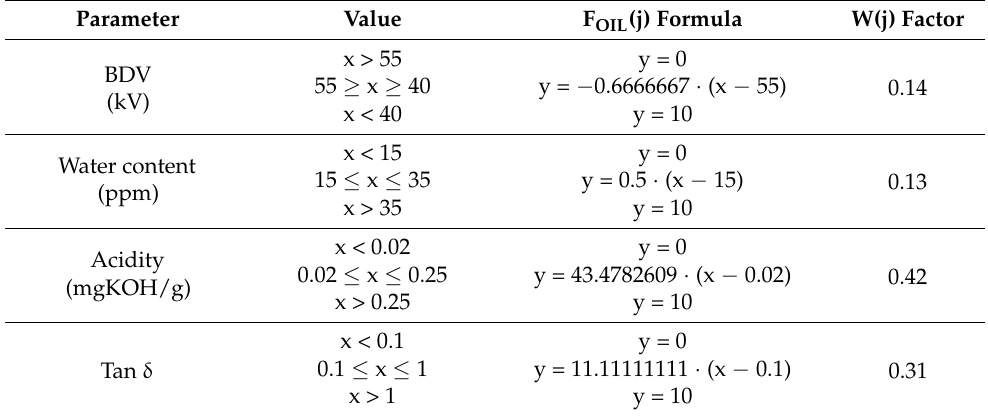
Table 2. The individual formulas and weighting factors used to evaluate the physicochemical properties of oil for transformers with the upper voltage of U ≤ 69 kV.